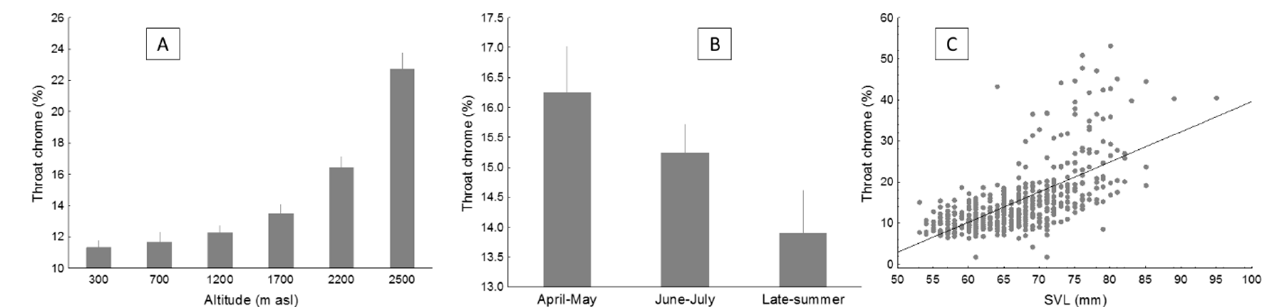
Figure 5. Average values of throat chroma (with SE) in the lizard P. algirus , according to altitude ( A ) and season ( B ), and the relationship between throat chroma and SVL ( C ). Notice that raw data are shown, but statistical analyses were per ‐ formed with transformed data when necessary.